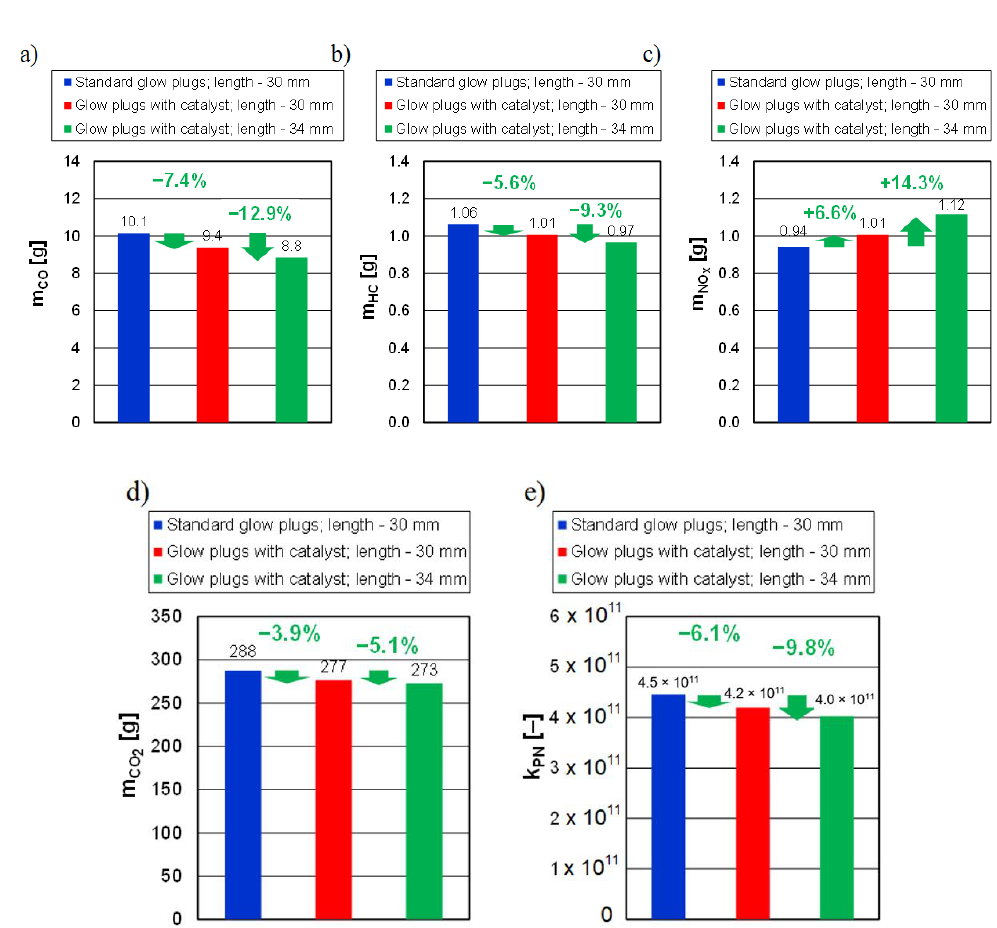
Figure 13. Comparison of the emission of carbon monoxide ( a ), hydrocarbons ( b ), nitrogen oxides ( c ), carbon dioxide ( d ), and particle number ( e ) during the tests of a diesel engine depending on the type of glow plugs and the length of the catalyst-covered ones.